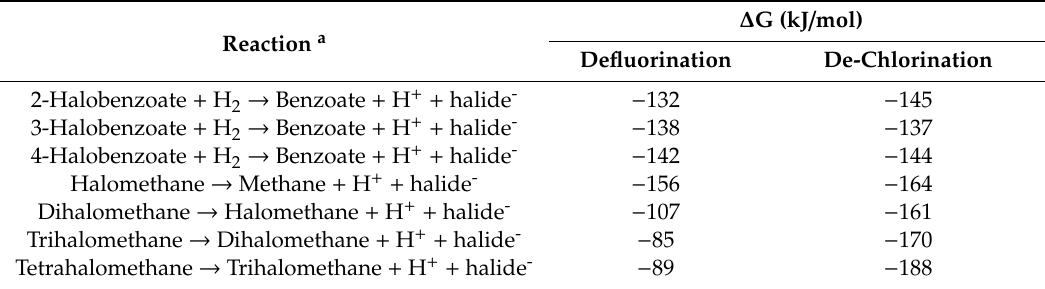
Table 4. Gibbs-free energy values for reductive dehalogenation of selected fluorinated aromatic and aliphatic compounds as well as their chlorinated analogues. Reaction a